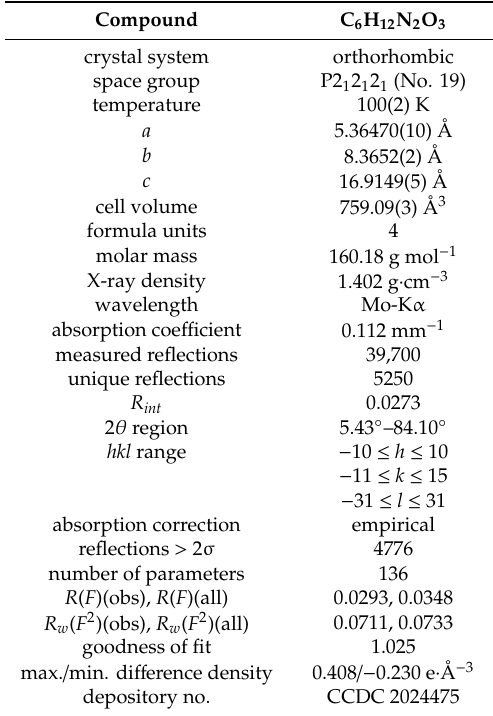
Table 1. Crystallographic data and details of the structure determination of γ -NADA at 100